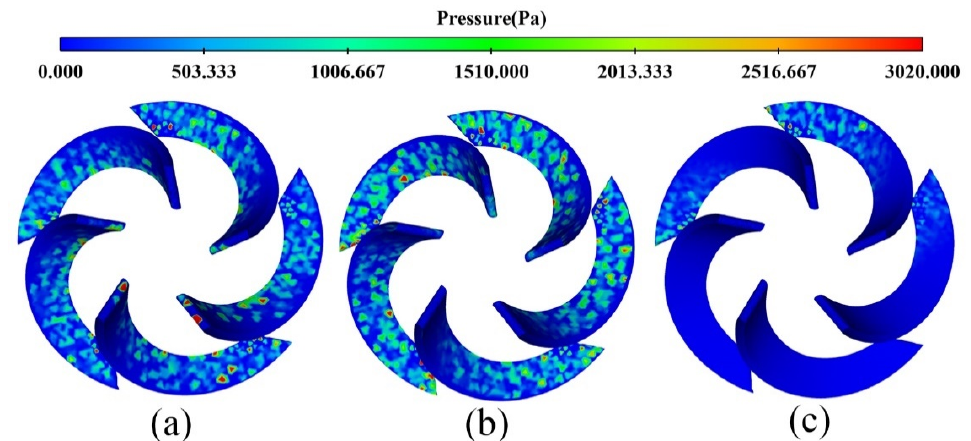
Figure 8. Pressure cloud on the guide vane after being collided with 10–20 mm particles: ( a ) pressure cloud graph at 2 s; ( b ) pressure cloud graph at10 s; ( c ) pressure cloud graph at 15 s.